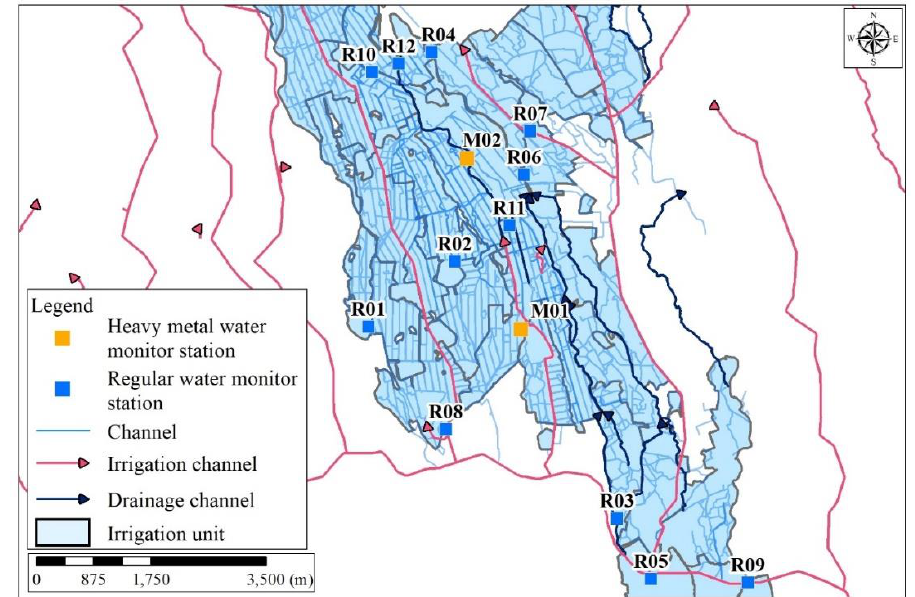
Figure 6. Spatial distributions and irrigation flow with monitoring stations in the study area. Note: R is a regular water monitoring station; M is a heavy metal monitoring station.